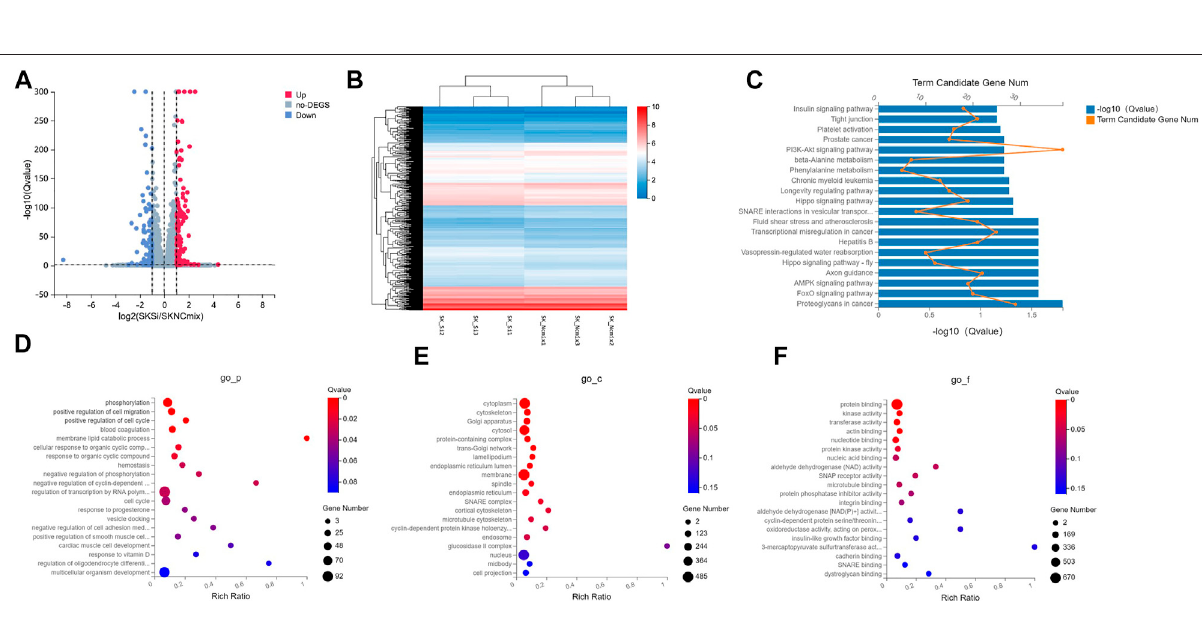
expression of IGFBP1 and FBN1 genes increased signi fi cantly after Figure 4A . Using the GeneMANIA online tool, we observed